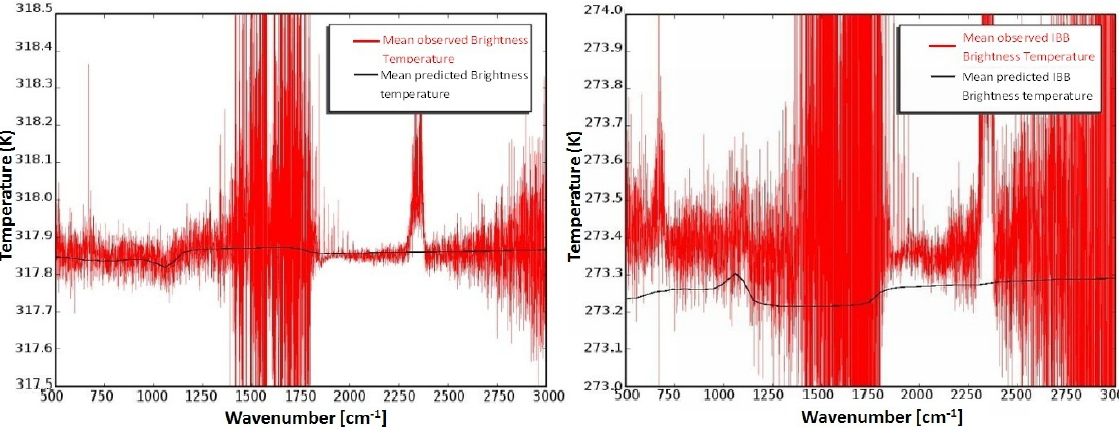
Fig. 3. Laboratory radiometric calibration verification “four-body” test results conducted at UW-SSEC on 27 September 2008 before deploy- ment to Eureka. Left panel: intermediate black-body brightness temperature spectrum. Right panel: IB brightness temperature spectrum. The measured spectrum (red) is the temporal-averaged calibrated radiance converted to equivalent blackbody brightness temperature. Note the y-axis range in both panels is 1K. The black line indicates the predicted blackbody temperature.